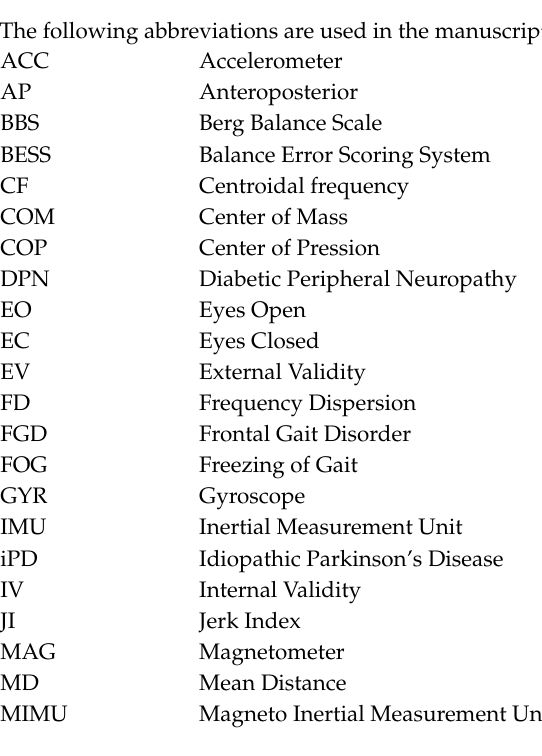
activities of the PolitoBioMedLab of Politecnico di